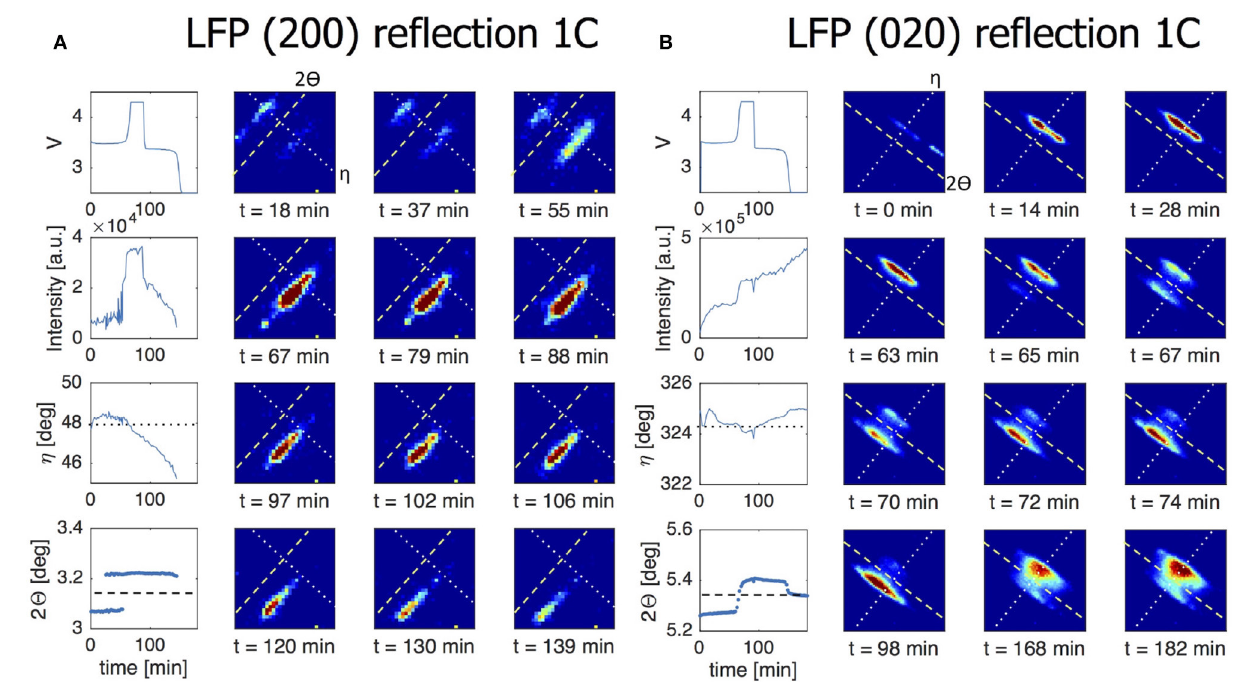
FIGURE 5 | The line charts in the left most column of both figures show from top to bottom the voltage of the battery, the intensity of the grain reflection, the change in the η angle and the change in the 2 2 angle for this particular grain reflection. All for a 1C charge/discharge cycle. The dotted line in the η graph corresponds to the dotted line shown in the 2D plots. The dashed line in the 2 2 graph corresponds to the dashed line in the 2D plots. (A) Direct view on a (200) reflection of an LFP grain during a 1C constant-current experiment. At t = 18 min both LFP and FP phases are visible, indicating phase coexistence occurs in this particular grain. The LFP phase is is visible from t = 0 – 55 min and the FP phase is visible from t = 18 – 146 min. (B) Here a (020) grain reflection is tracked during a 1C experiment. The phase transition from LFP to FP at the end of charge is not complete as some intensity is still visible for LFP. At the end of discharge clear solid solution behavior is on display where this grain never fully transitions back to